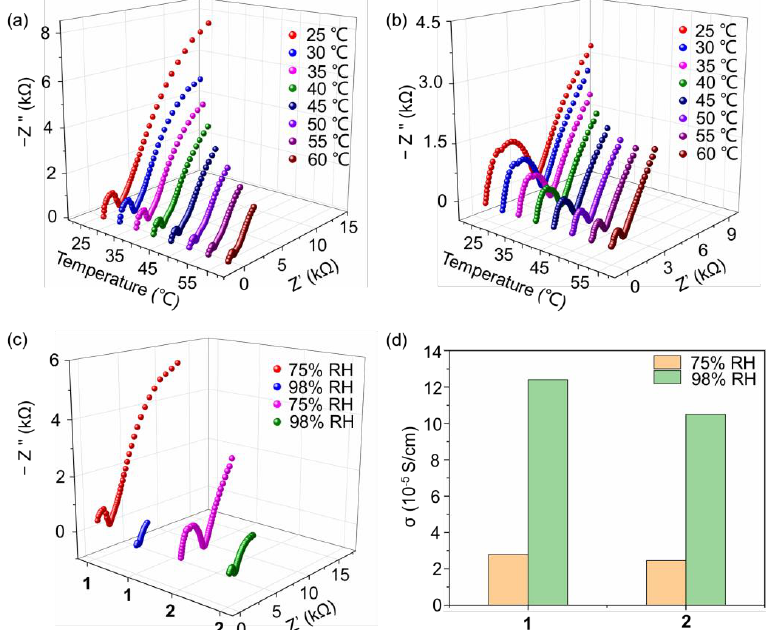
Figure 4. Nyquist plots of compounds ( a ) 1 , and ( b ) 2 at various temperatures and 75% RH; ( c ) Nyquist plots of compounds 1 and 2 under the conditions of 75% and 98% RH at 30 °C; ( d ) proton conductivity of compounds 1 and 2 under different conditions.